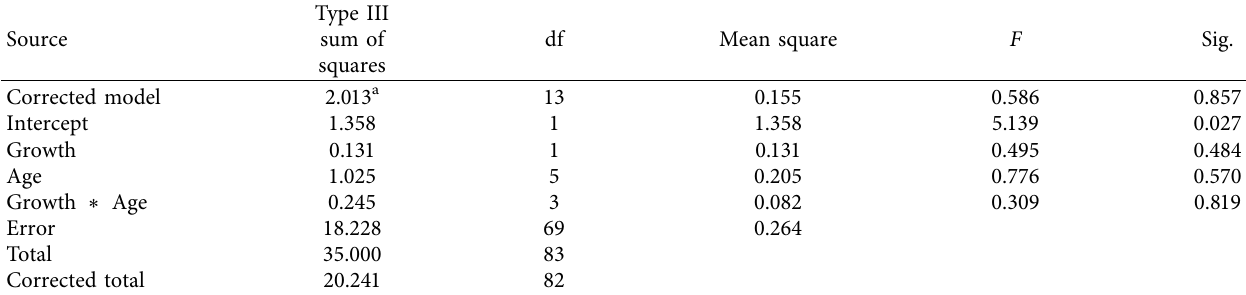
Table 7: Gender bivariate statistical analysis, dependent variable: gender.